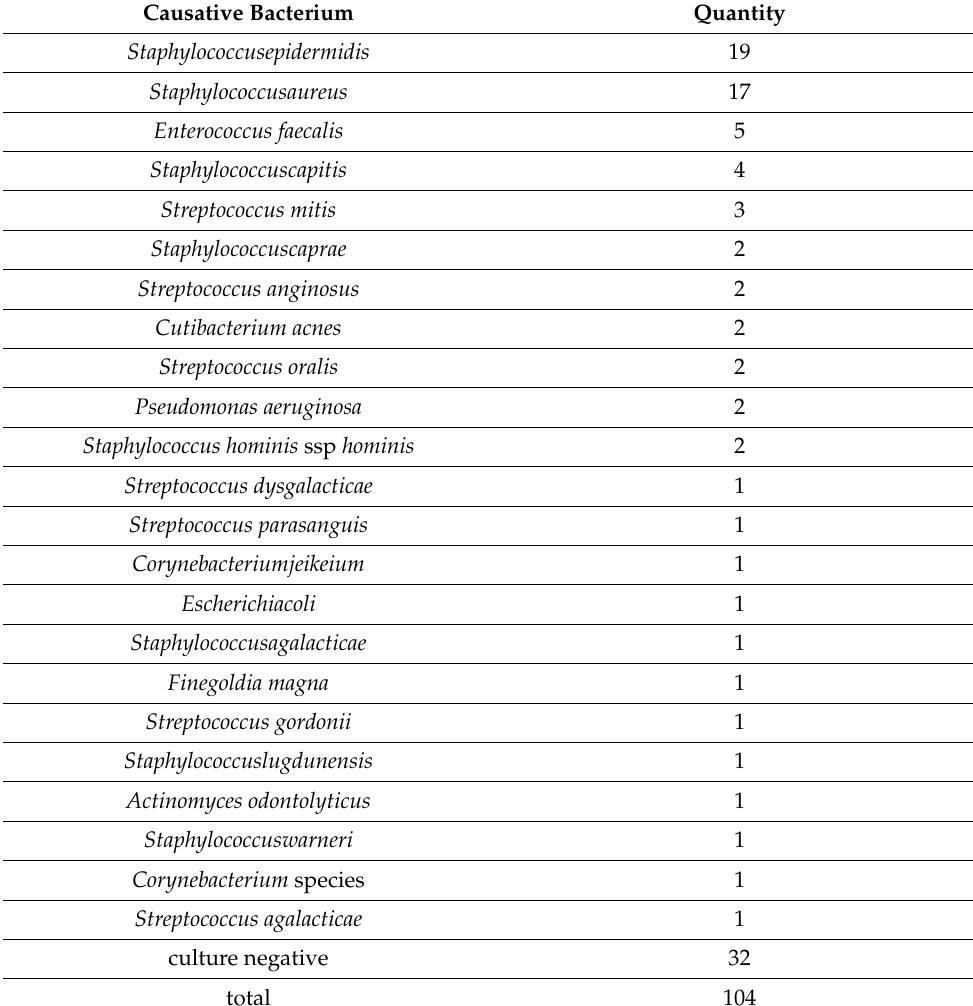
Table 1. List of all causative bacteria cultivated from preoperative or intraoperative samples and the number of patients in which each was